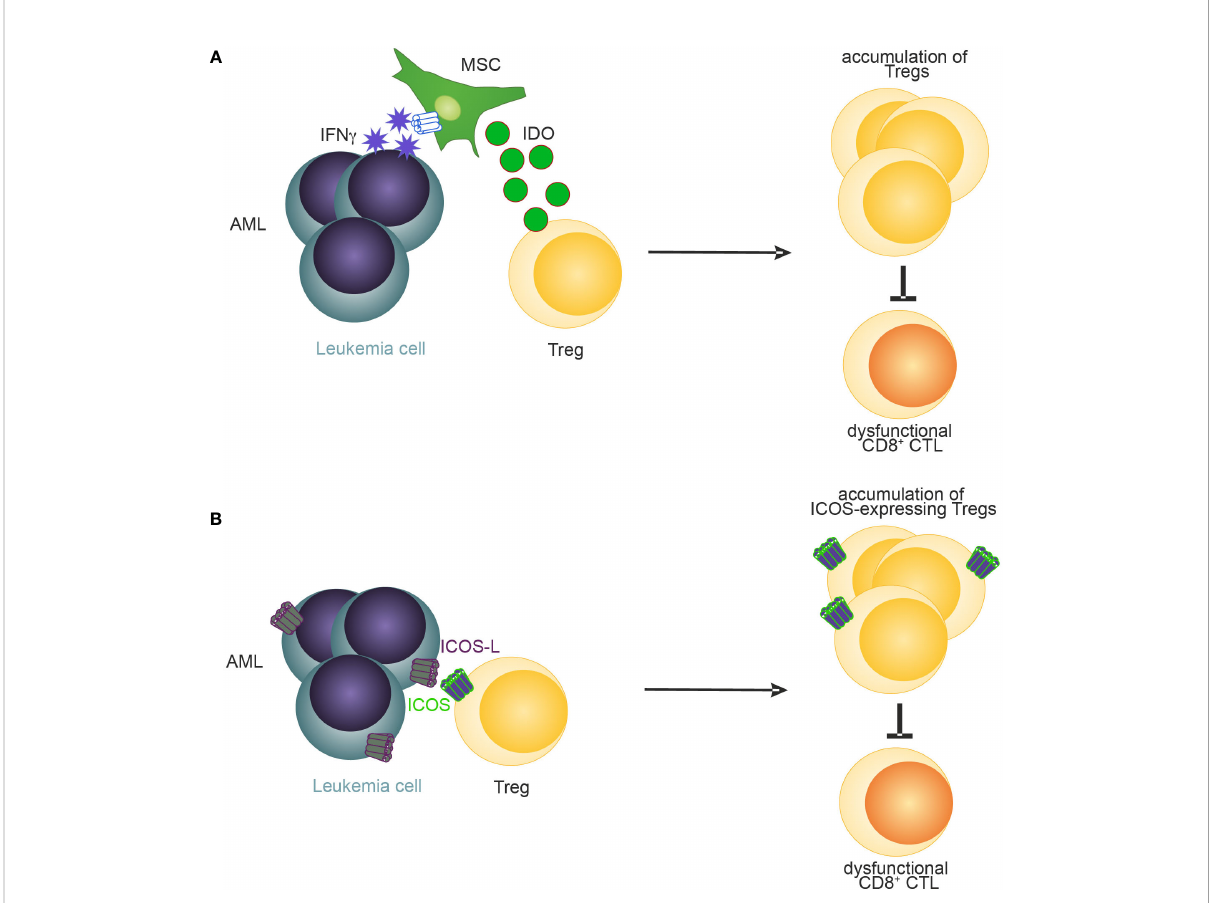
FIGURE 3 A schematic illustration of reported mechanisms leading to accumulation of Tregs in AML. (A) MSC-derived IDO (94) and (B) ICOS-ICOSL signaling (97) promotes the accumulation of Tregs in